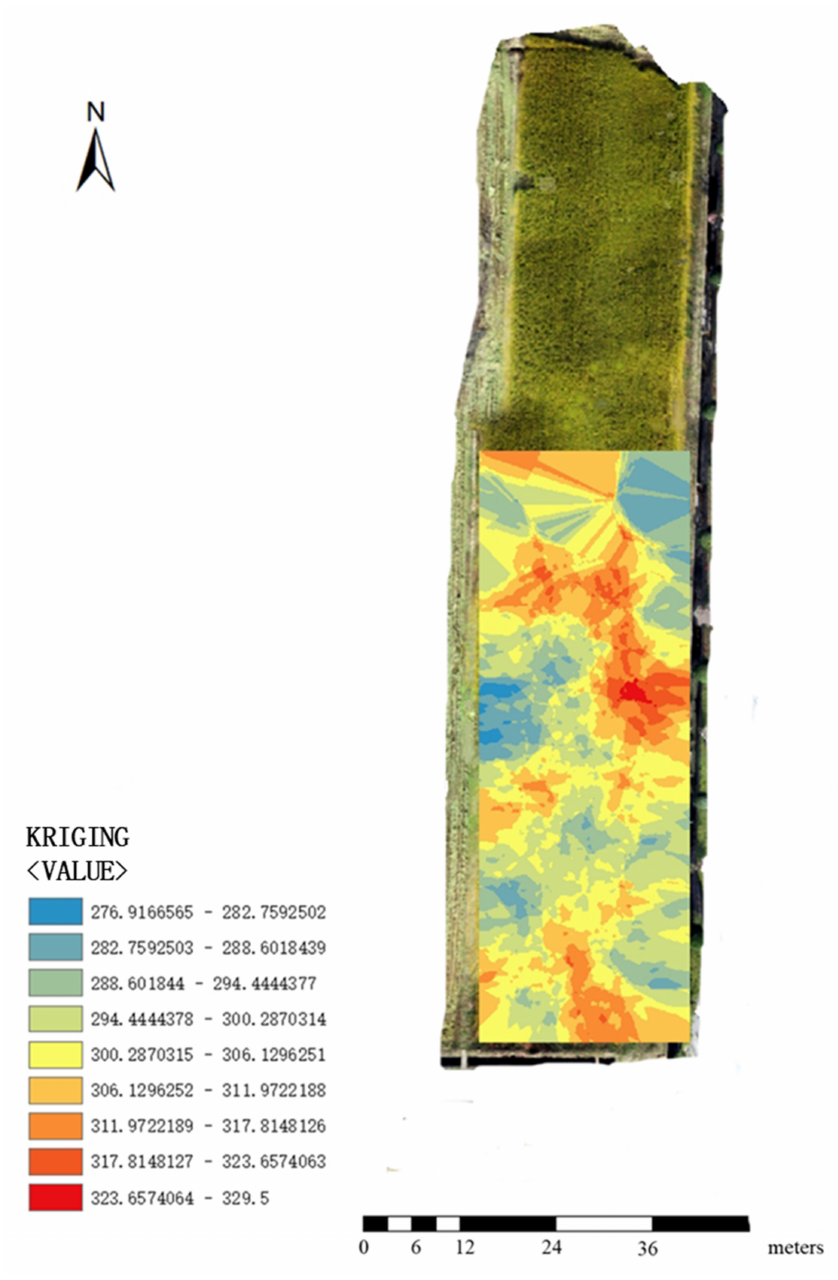
Figure 13. Rice Density Prescription